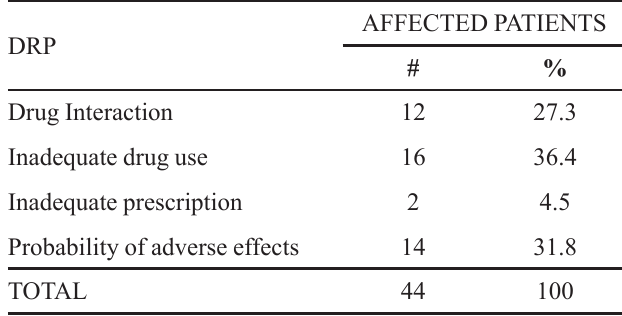
TABLE II - Incidence Of Psychotropic Related